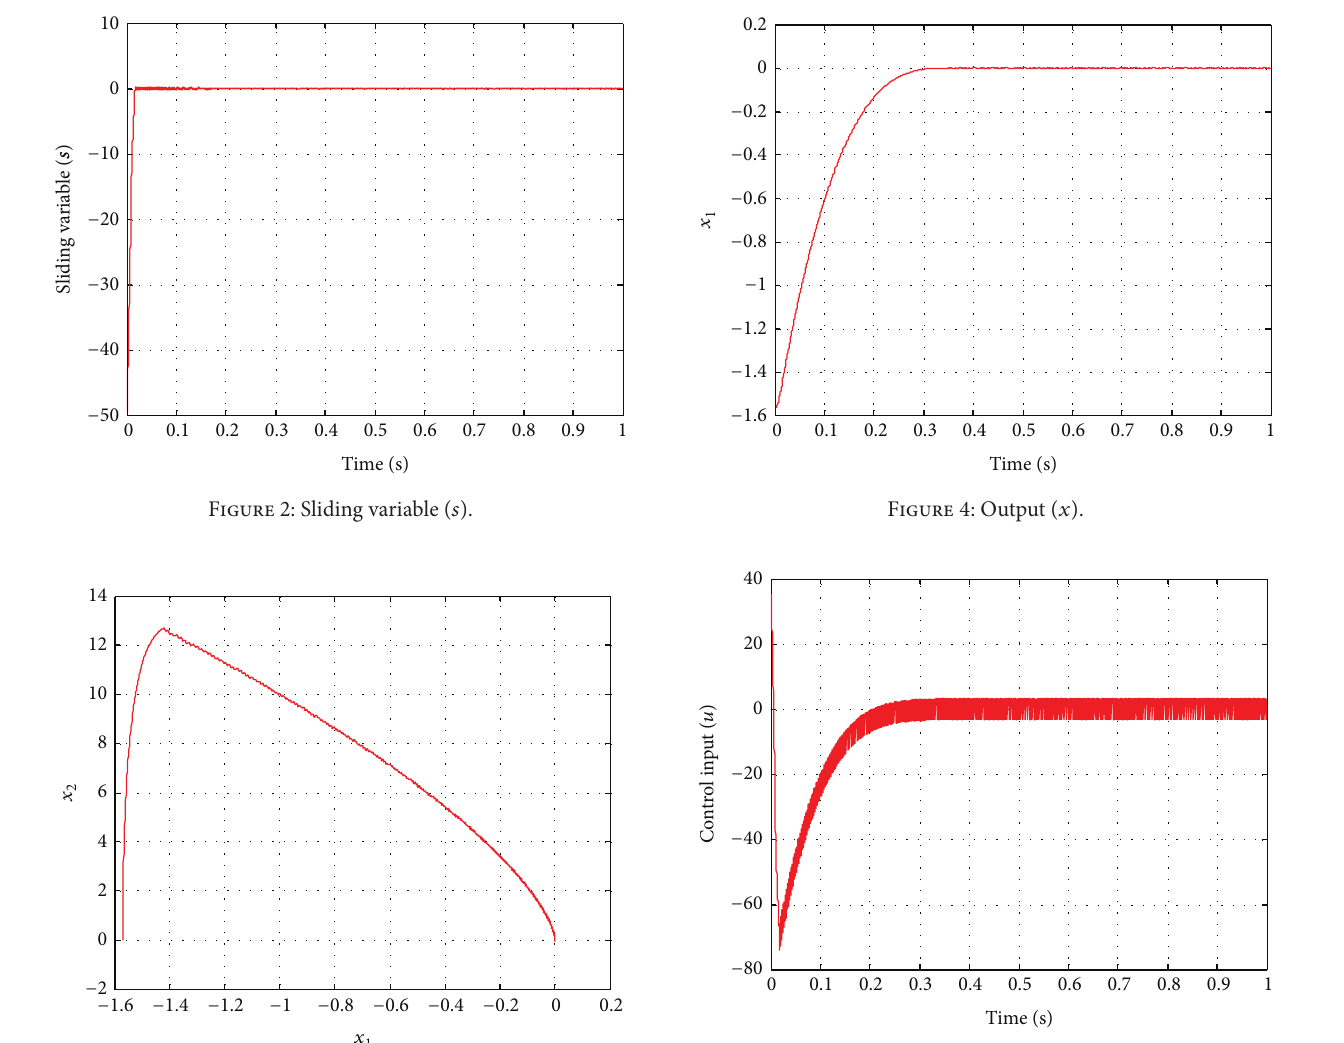
Figure 3: Phase portrait ( 𝑥 versus ̇𝑥 ).